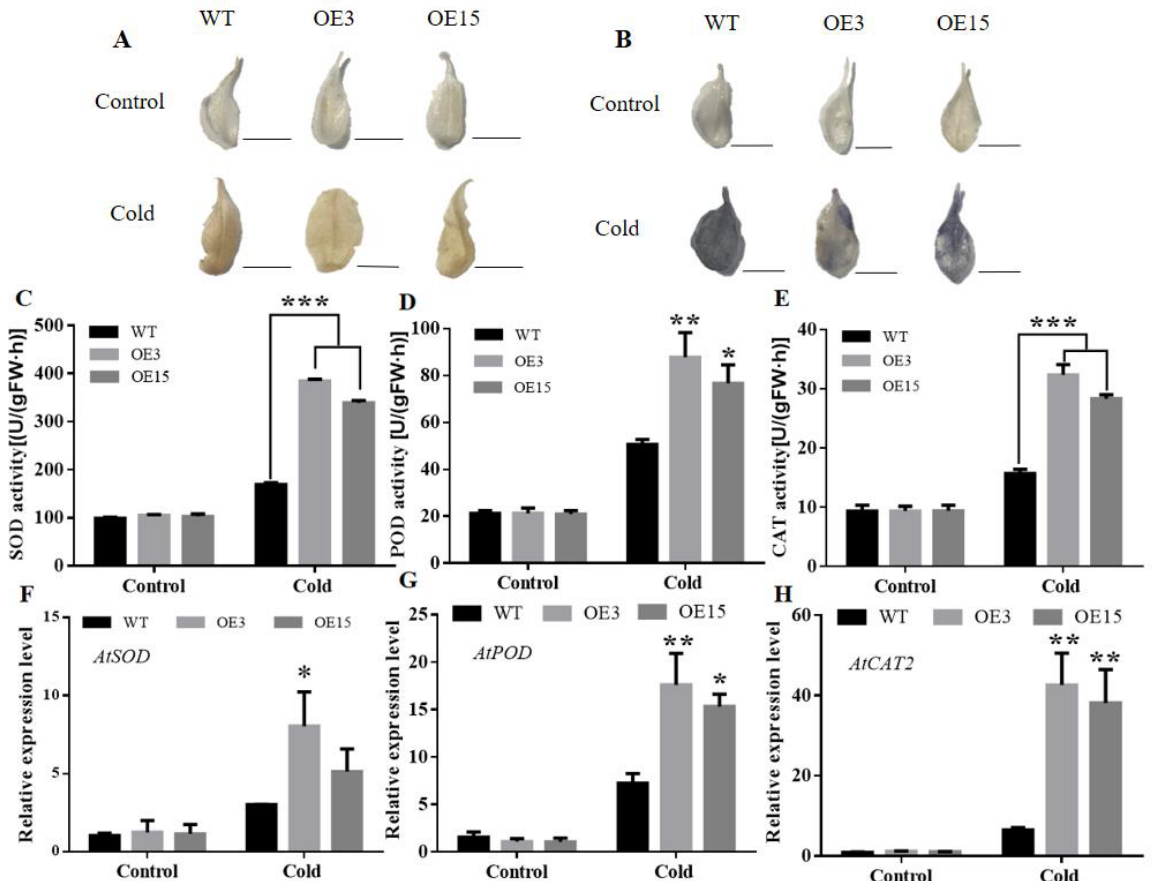
Figure 7. Reactive oxygen species (ROS) levels in WT and transgenic Arabidopsis under cold stress. ( A ) DAB staining. ( B ) NBT staining. The black line is used as a scale bar (length 0.8 cm). ( C ) SOD activity. ( D ) POD activity. ( E ) CAT activity. ( F – H ) RT-qPCR analysis of AtSOD , AtPOD, and AtCAT2 . All data of three independent biological replicates were expressed by Means ± SDs. * representing significant difference (* p < 0.05, ** p < 0.01, *** p < 0.001).